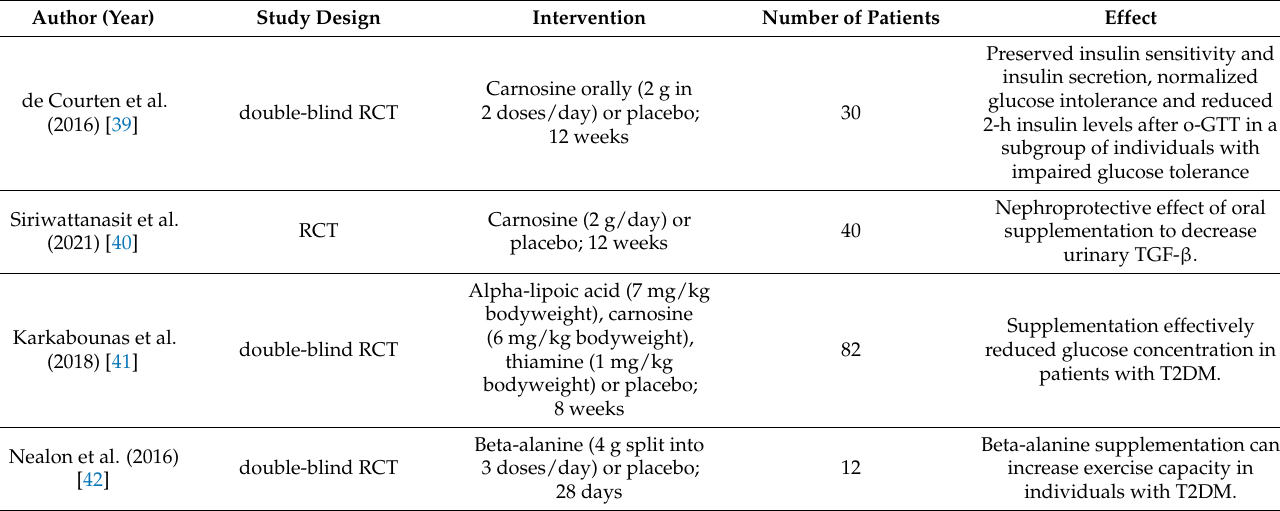
Table 1. Carnosine, beta-alanine and diabetes